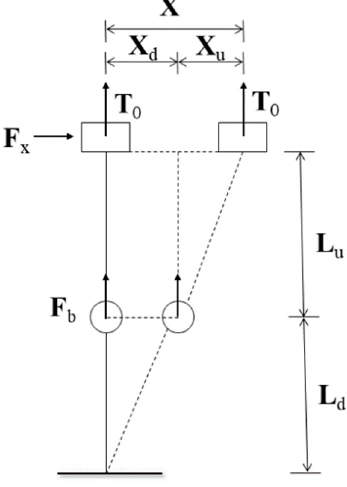
Figure 3. Force diagram of tendons with series connected buoy.